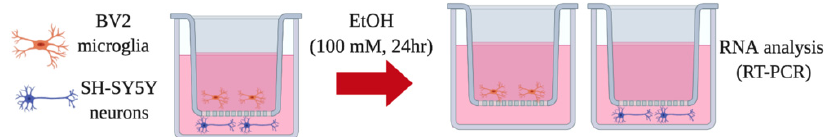
Figure 1. Transwell co-culture model for examining ethanol-induced changes in BV2 microglia and SH-SY5Y.